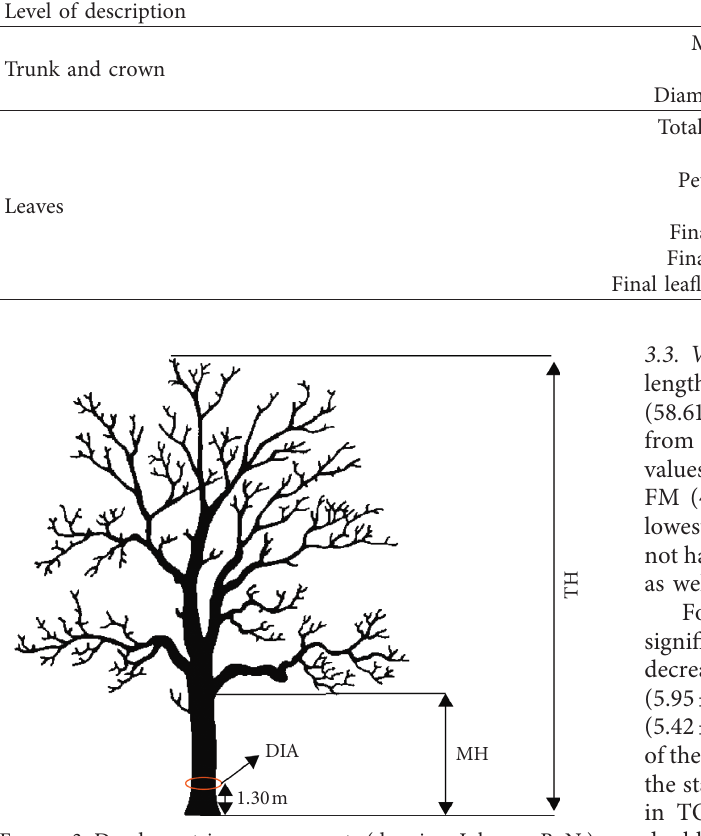
Figure 3: Dendrometric measurements (drawing: Johnson B. N.).